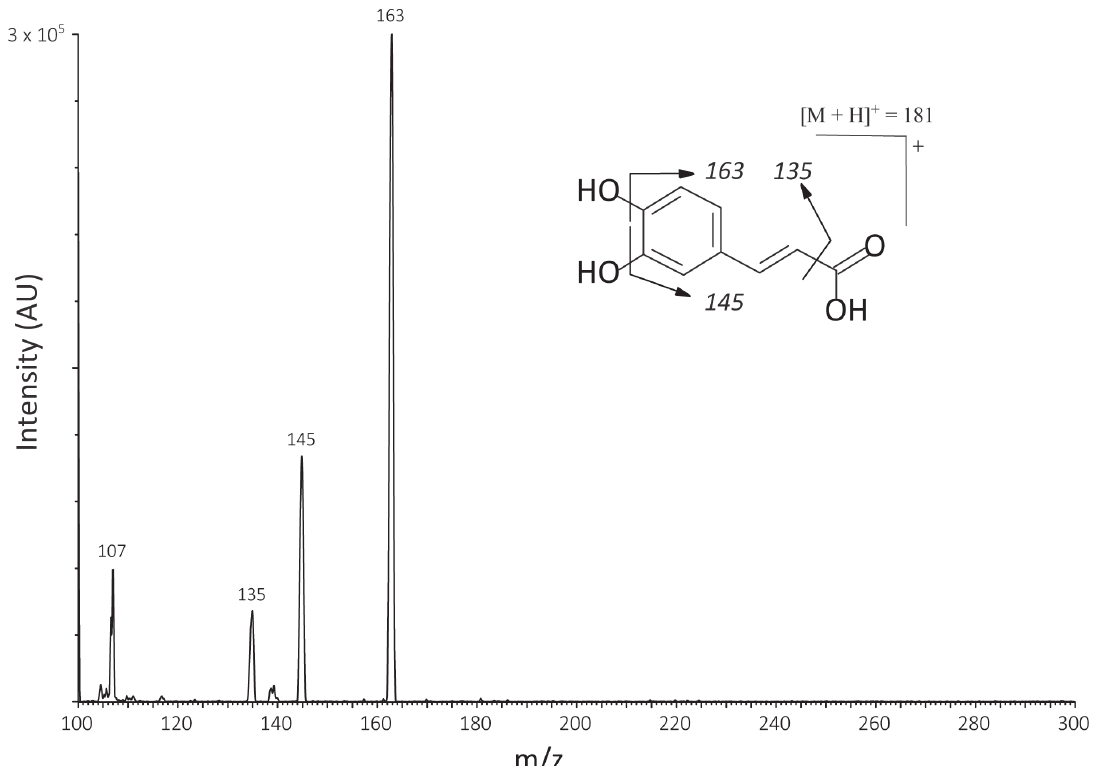
Figure 3 - Profile fragmentation of standard caffeic acid. The analysis by mass spectrometry Quattro II (Micromass, Manchester, UK) with source ionization ESP + monitoring of the m/z = 181 → 163. Parameters of the mass spectrometer: Source temperature 100 °C; Desolvation temperature 150 °C; Capillary voltage 2.5 kV; Cone voltage 25 V, Collision energy 15